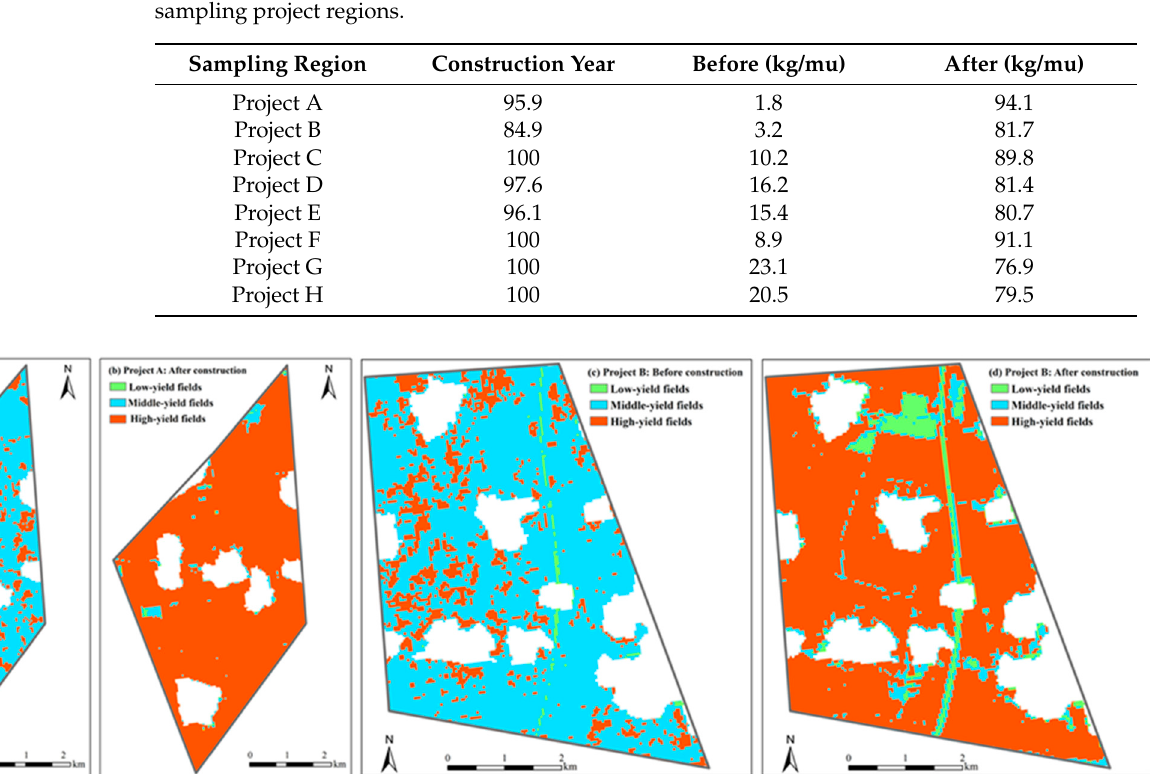
Figure 8. Distribution of middle–low productive cropland before and after the HSF construction (Projects A and B are examples). (Projects A and B are